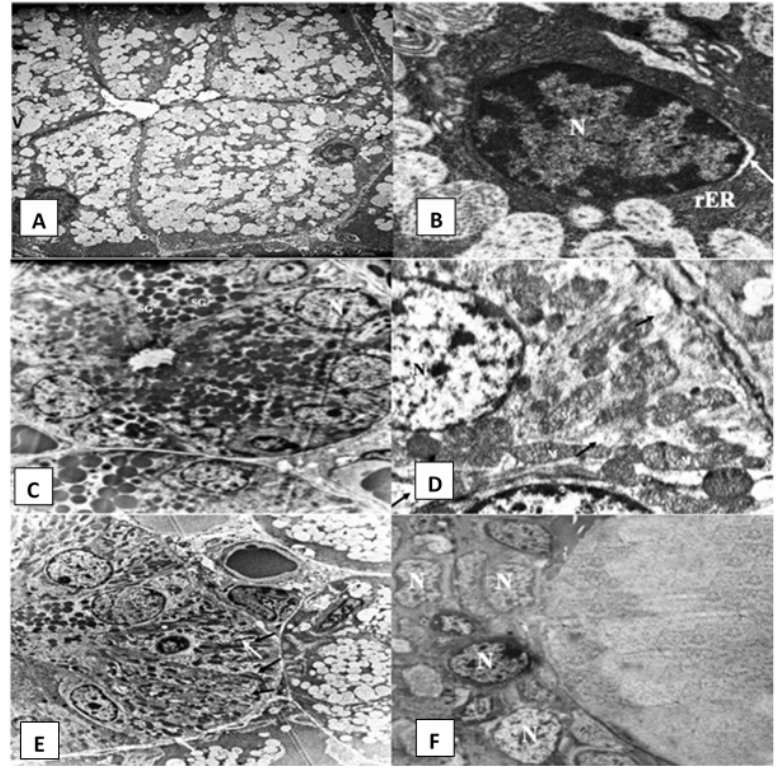
Figure 4. Electromicrographs of the rosemary treated group showing ( A ) serous acinus containing nucleus (N), numerous secretory granules and few cytoplasmic vacuoles (uranyl acetate and lead x 5000). ( B ) Open face nucleus (N) of an acinar cell and parallel arrays of rough endoplasmic reticulum (rER) with slight dilatations in some areas. Slight perinuclear space can be noticed (arrow) (uranyl acetate and lead x 12000). ( C ) Granular convoluted tubule (GCT) containing basally situated nuclei (N) and numerous electron dense secretory granules (SG) (uranyl acetate and lead x 2500). ( D ) Striated duct cell with open face nucleus (N) and tubular shaped mitochondria (M). Minimal cytoplasmic degeneration and some loss of basal infoldings can be observed (black arrows) (uranyl acetate and lead x 12000) ( E ) Striated duct columnar cells with basal infoldings (black arrows) and numerous rod shaped mitochondria (white arrows) (uranyl acetate and lead x 5000). ( F ) Excretory duct with pseudostratified epithelium lining cells presenting open face nucleus (N) (uranyl acetate and lead x